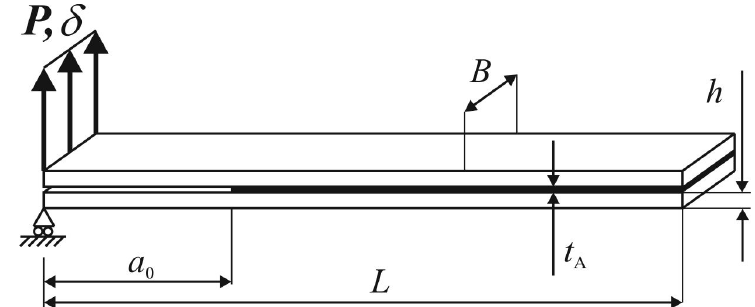
Figure 1: Geometry and characteristic dimensions of the DCB specimens.